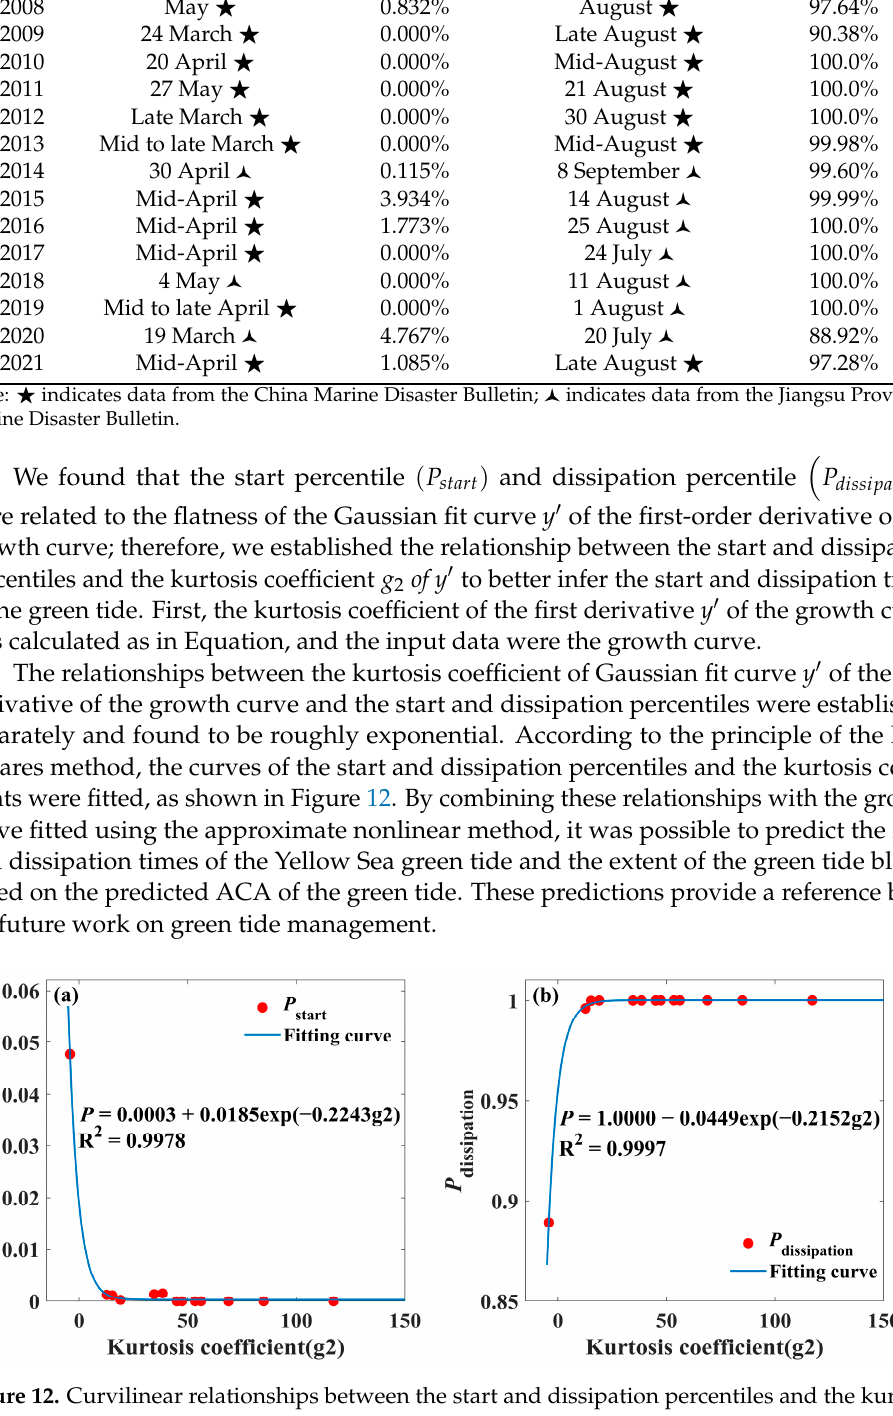
Data for predicting the 2022 green tide were extracted from multi-source RS images. The available data were for four scenes, which were combined with the approximate non- linear method to fi t the predicted growth curve of this green tide for 2022. According to the prediction results (Figure 13), the bloom time was expected to be from 1 June to 15 August 2022, the duration was expected to be 73 days, and the ACA was expected to be approximately 1190.90–1191.21 km 2 . Compared with the green tide data from recent years, the predicted bloom duration and ACA in 2022 were respectively shorter and smaller, suggesting that this would be a smaller green tide bloom event in the Yellow Sea than those seen in recent years (see Figure 14). For the true condition of 2022, according to the Ministry of Natural Resources of the People’s Republic of China, the 2022 pre-salvage operation of the Yellow Sea green tide began on May 19 and fi nished around mid-August in coastal cities such as Yantai. In ad- dition, the bloom was much smaller than last year. The actual duration and bloom condi- tion were roughly in line with our predictions. In fact, there have been a lot of arti fi cial measures for the Yellow Sea green tide in recent years, such as arti fi cial salvage, which is bound to have an impact on prediction. However, we believe that these human factors may a ff ect the accuracy of the results over a short period but will not a ff ect the general direction of the forecast. One was that the main function of the prediction model was to get a rough estimate of the size of the green tide blooms and to know its bloom duration and in fl ection point. The second was that monitoring was a dynamic process; for example, we did not know whether this RS image we selected was before or after arti fi cial salvage. In addition, salvage and defense measures are mainly inshore, so the impact on the center of the sea is limited. However, the positive impact of human intervention is also one of the hot topics of a tt ention, and we will pay further a tt ention to this content. In addition to human factors, climate factors can also impact the green tide. Therefore, we also tried a predicted model